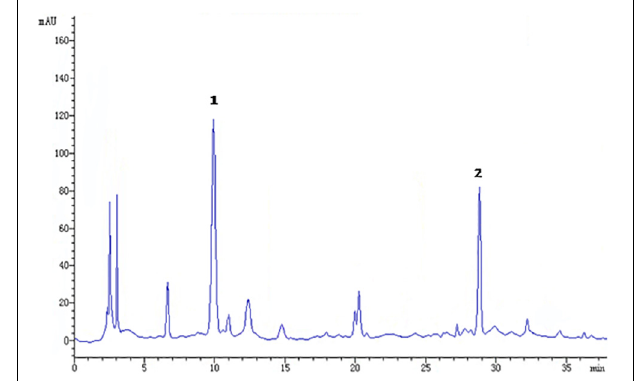
FIGURE 1 | Chromatographic profile of Gan-Mai-Da-Zao (GMDZ) decoction; 1, liquiritin; 2, ammonium glycyrrhizinate. Chromatographic separation was achieved on a Kromasil 100-5 C18 column maintained at 25 ◦